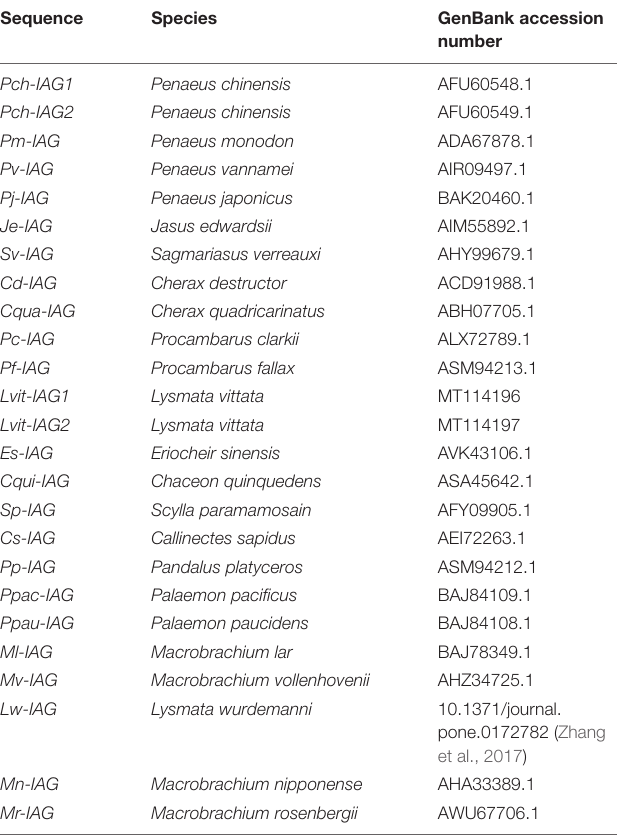
TABLE 2 | Summary of IAG sequences used in multiple sequence alignment and phylogenetic analysis.